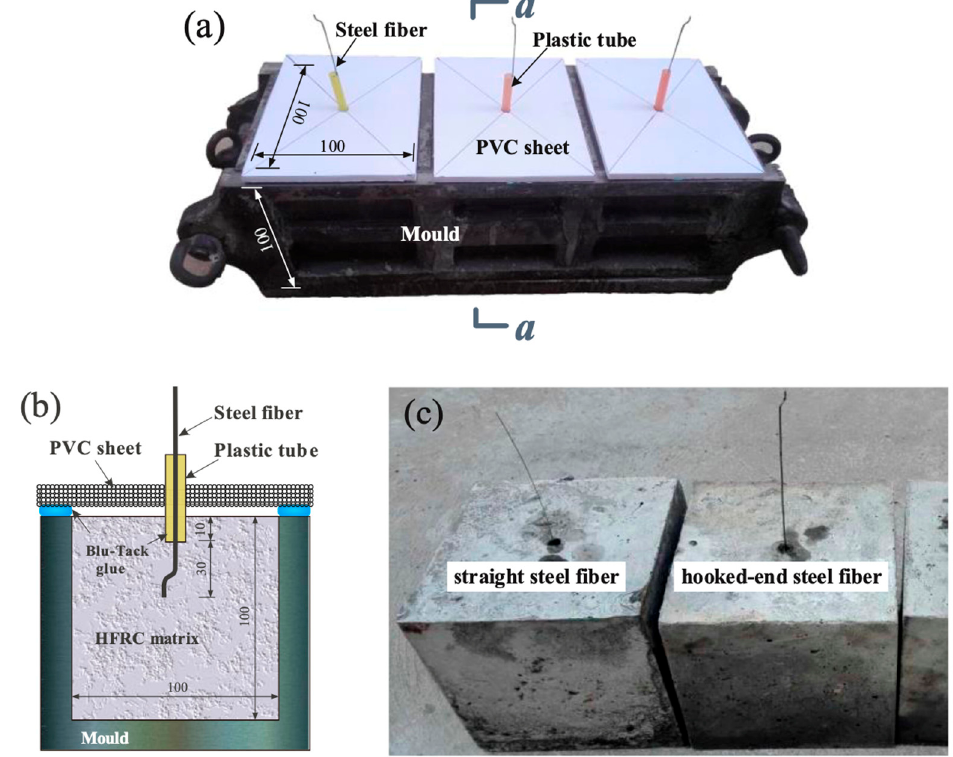
Figure 9. ( a ) Specimen casting in the moulds; ( b ) a–a cross-section; and ( c ) extracted pull-out specimens [11].